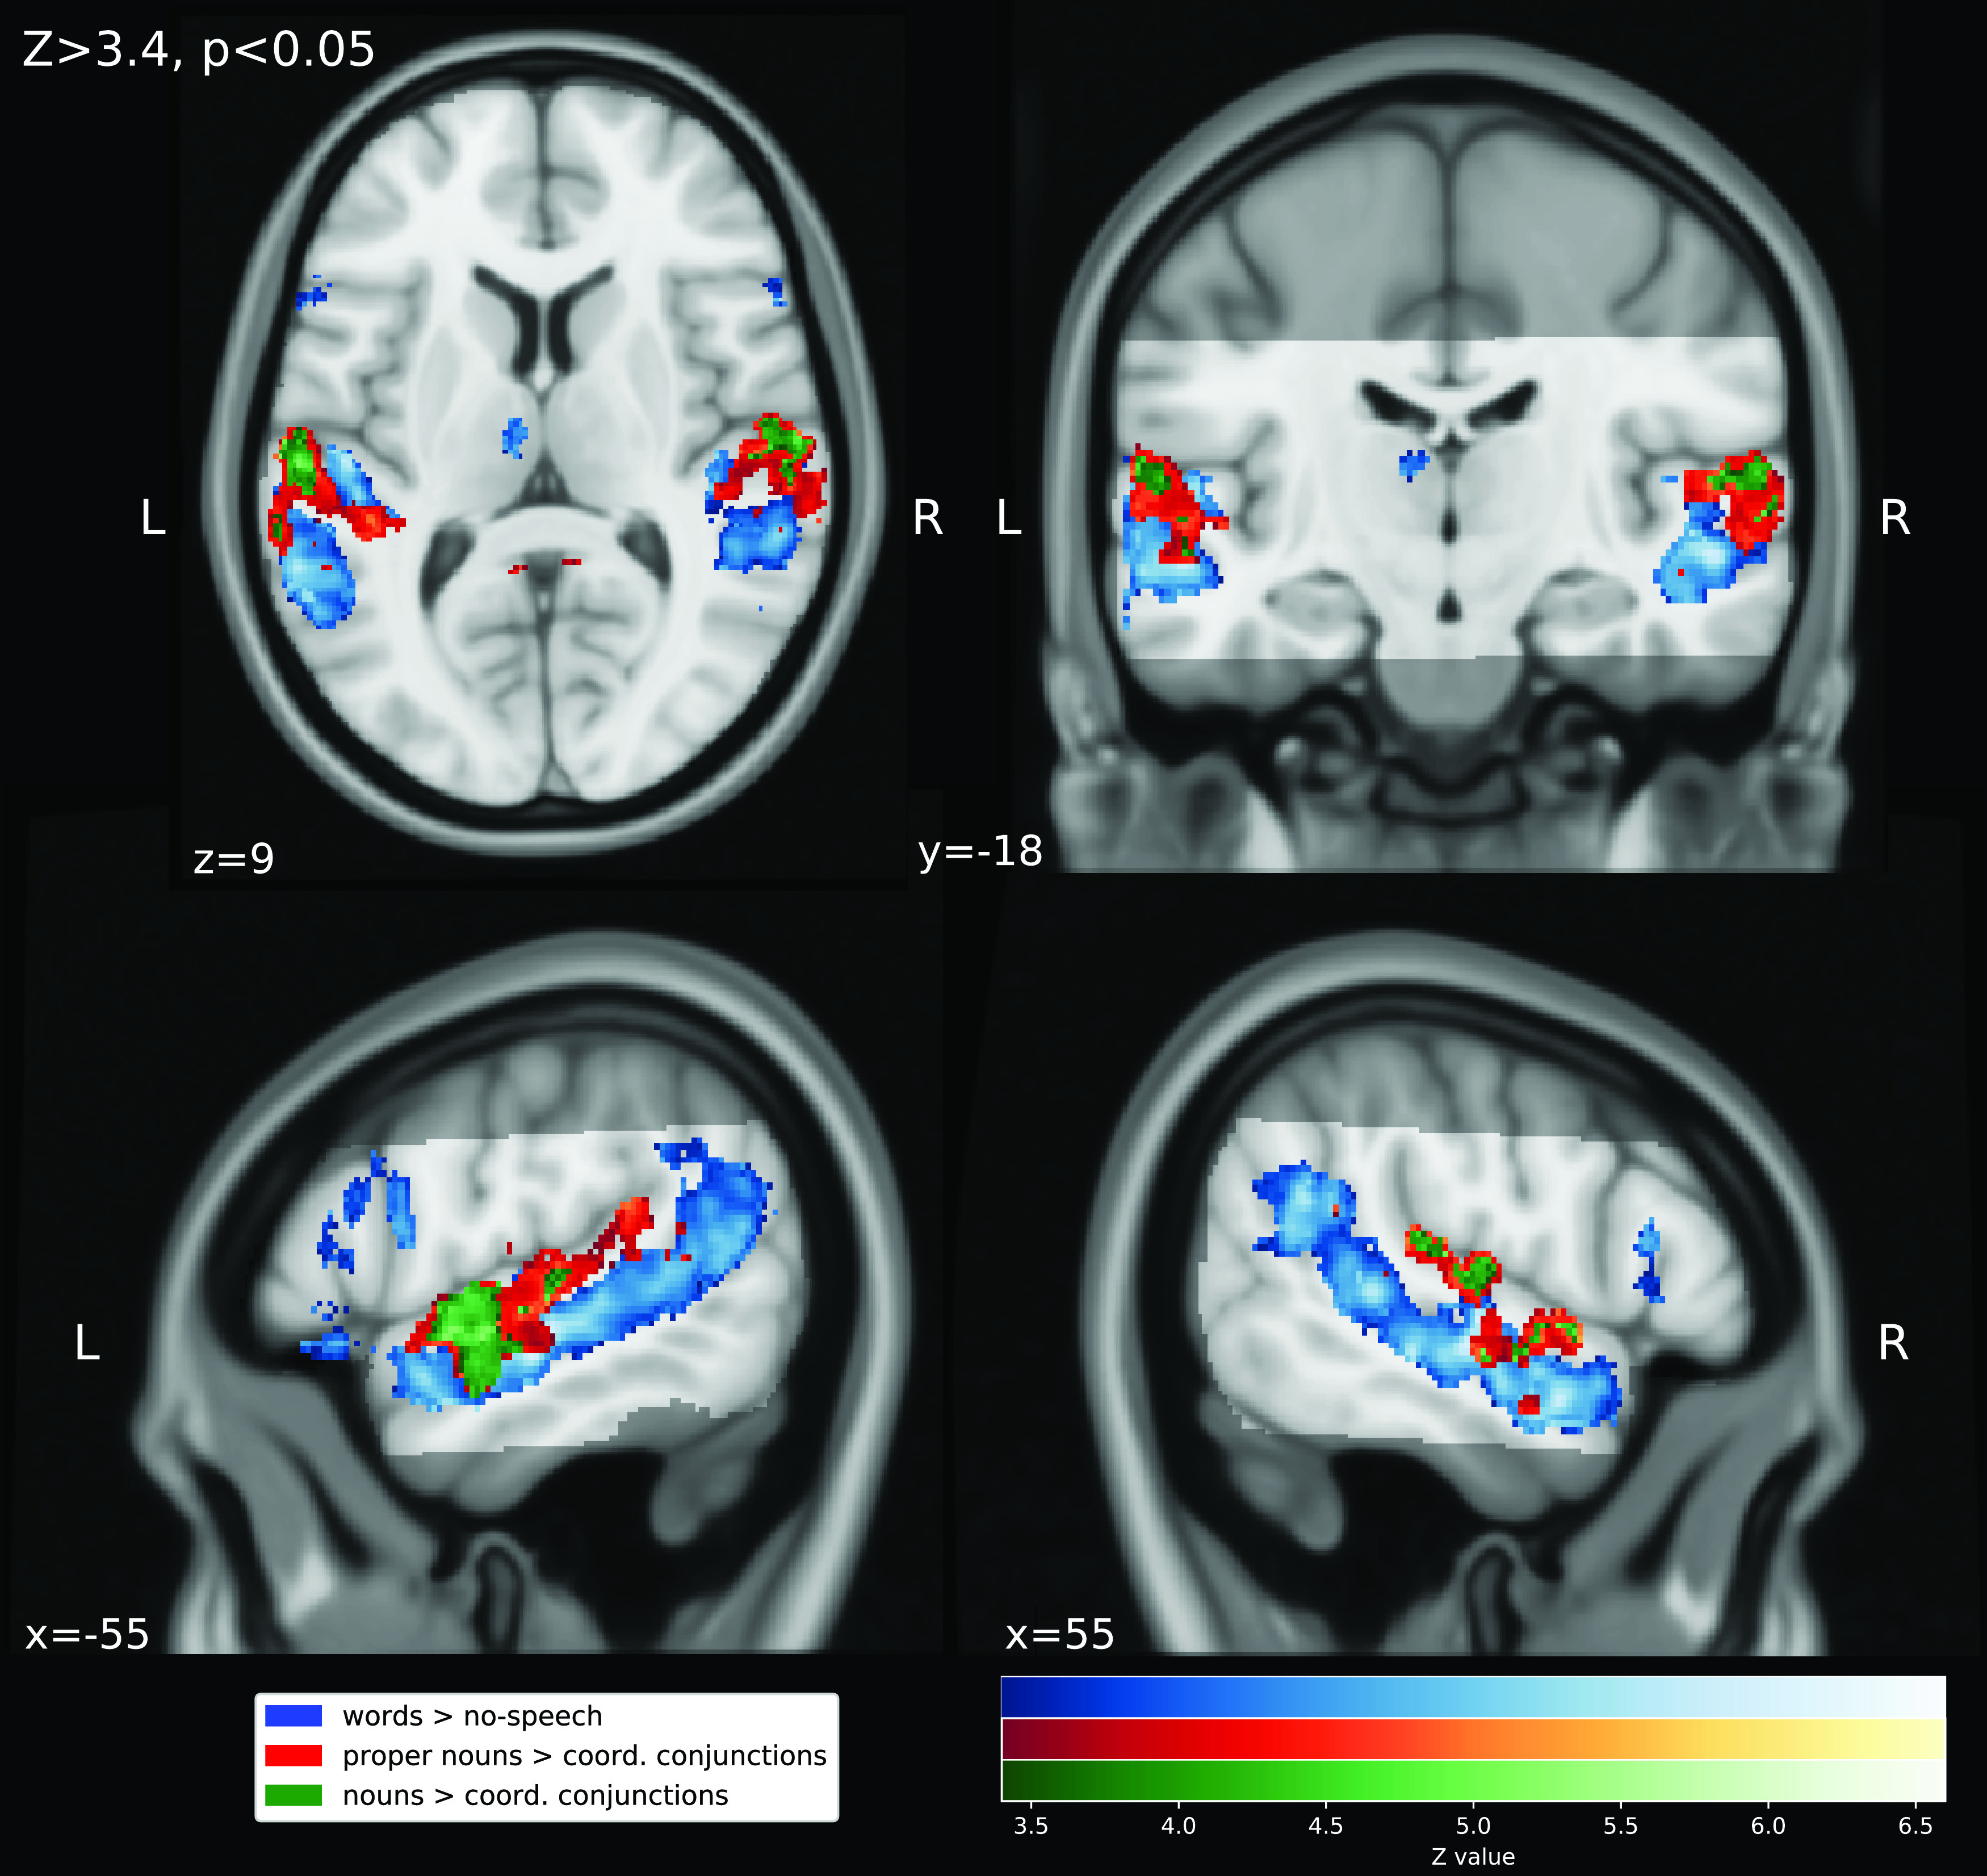
Results of the mixed-effects group-level (N=14) GLM
t-contrasts for the audio-description of the movie “Forrest Gump”.Significant clusters (Z>3.4, p<0.05 cluster-corrected) are overlaid on the MNI152 T1-weighted head template (grey). Light grey: the audio-description dataset’s field-of-view (cf.
17).